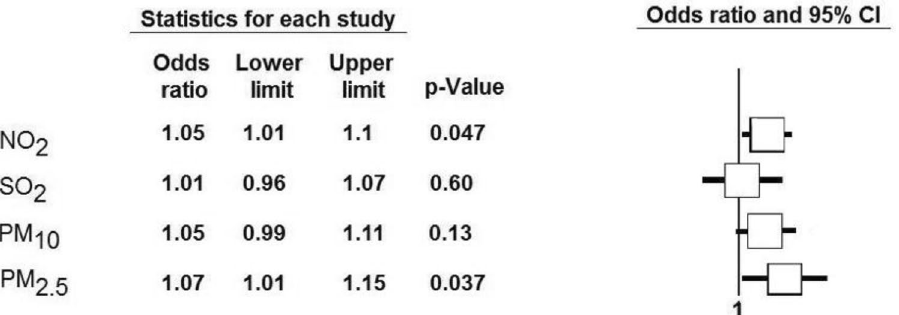
Figure 2. Multivariable logistic regression model. Estimated associations of the increase by interquartile range of yearly air pollution and chronic kidney disease. Model was model was adjusted for seasonality and long- time trends, weather conditions: temperature, humidity, atmospheric pressure, age, sex, and clinical variables including obesity, atrial fibrillation, hyperlipidemia, diabetes mellitus, arterial hypertension. Abbreviations : NO 2 , nitrogen dioxide; PM 2.5 , particulate matter with a diameter of 2.5 μm or less; PM 10, particulate matter with a diameter of 10 μm or less; SO 2 , sulfur dioxide.